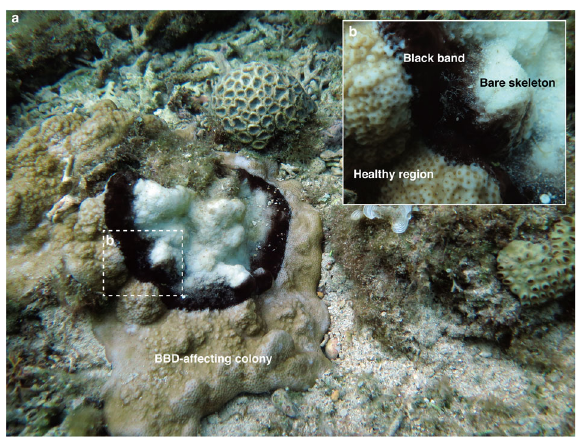
Fig. 1 A coral colony Montipora sp. being infected by black band disease (BBD) in Aka Island, Okinawa, Japan. Representative BBD on enclosing Montipora sp. colony ( a ). Close-up of the interface showing black band, which was composed of cyanobacterial mat between live coral tissue (healthy region) and exposed coral white skeleton (bare skeleton) ( b